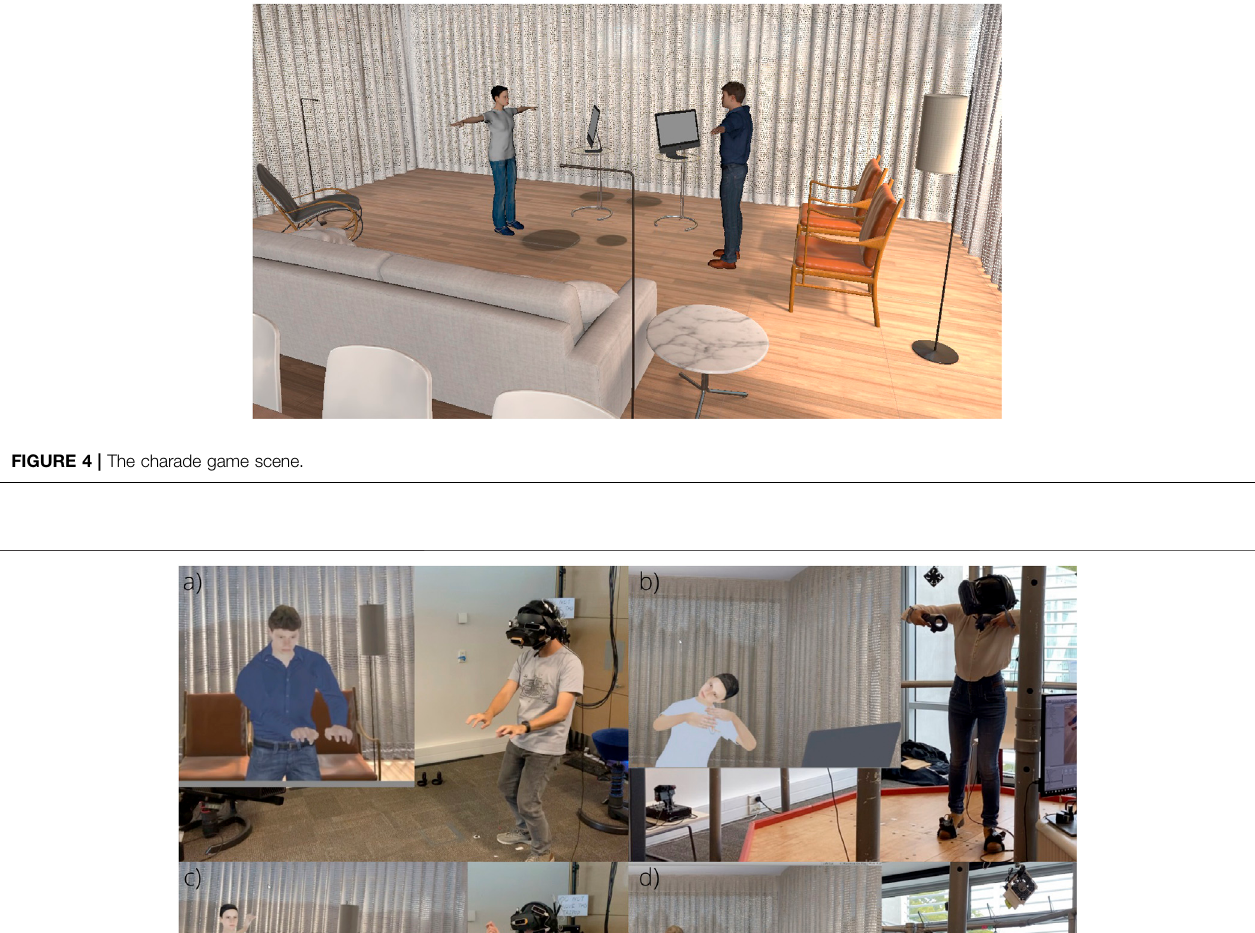
Frontiers in Virtual Reality |